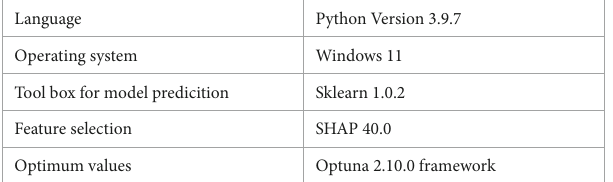
TABLE 2 Software